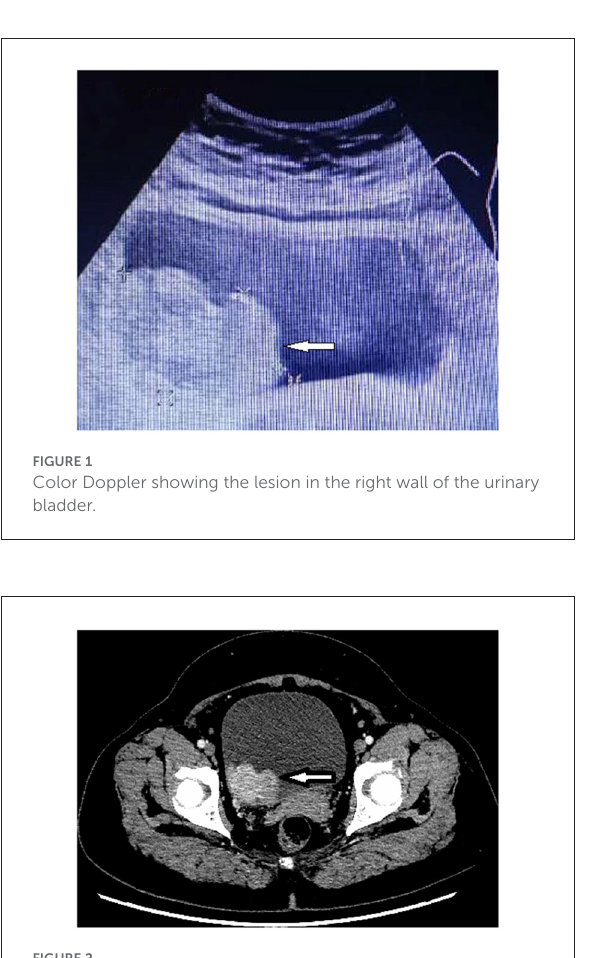
FIGURE2 CT enhancement showing the lesion in the right wall of the urinary